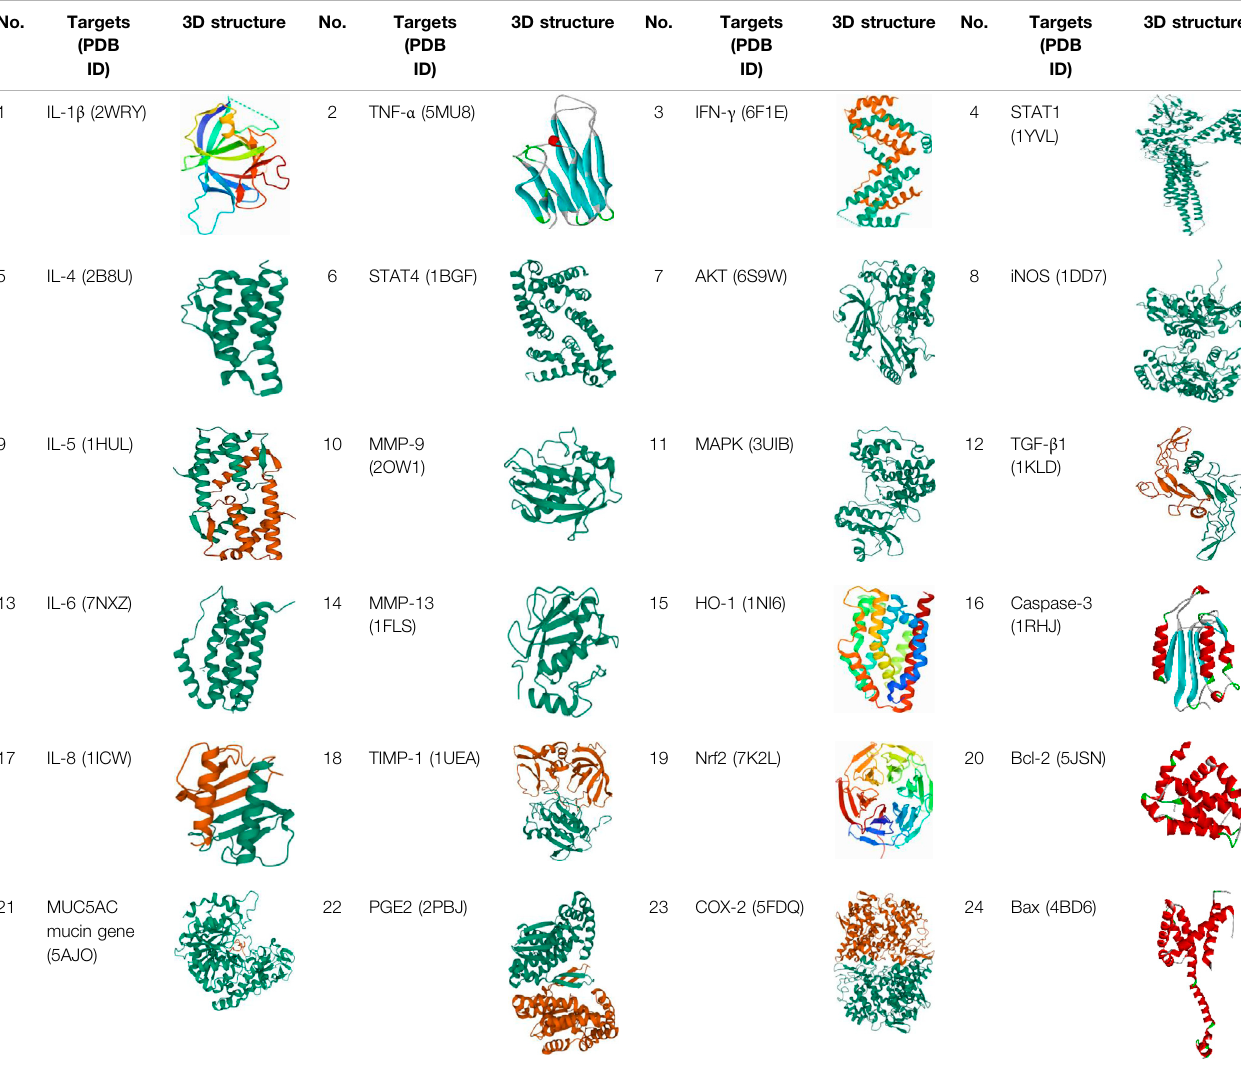
TABLE 5 | The main related targets of BFC effect on respiratory diseases